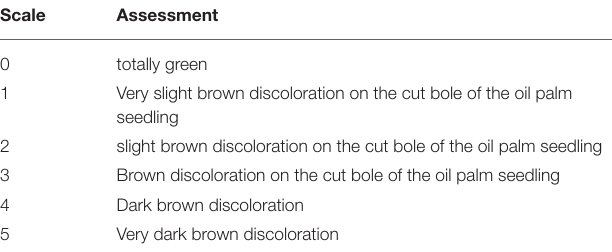
TABLE 1 | Disease severity